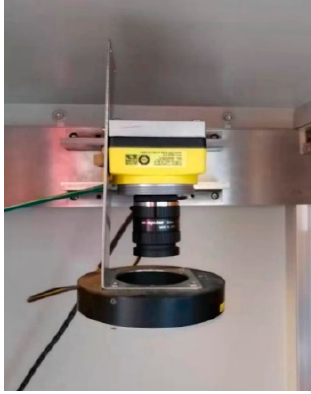
Figure 7. Image acquisition platform.